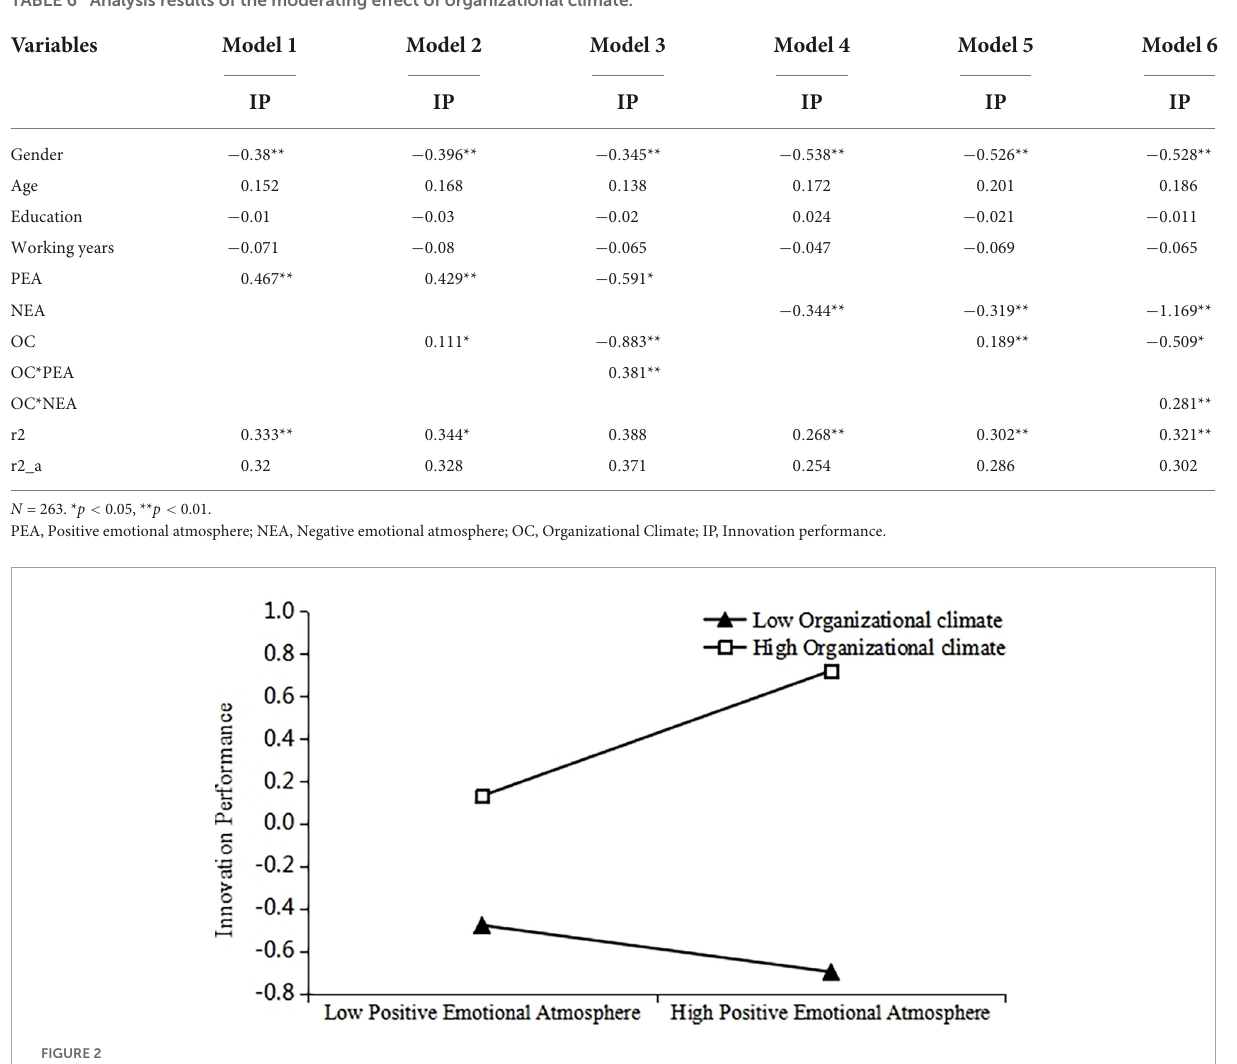
TABLE 6 Analysis results of the moderating effect of organizational climate.